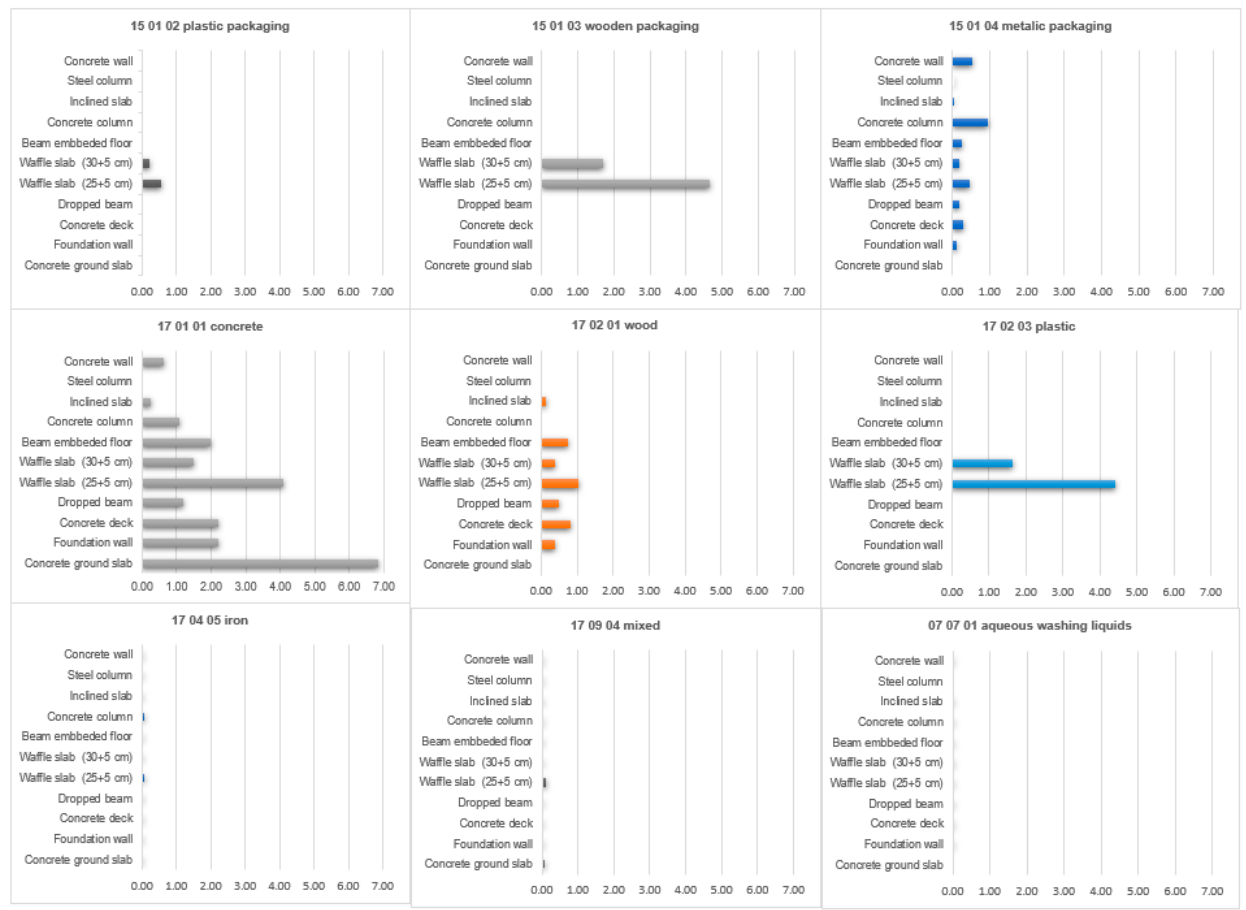
Figure 8. Chart with results produced in Excel obtained from reports in Allplan, Archicad, and Revit.